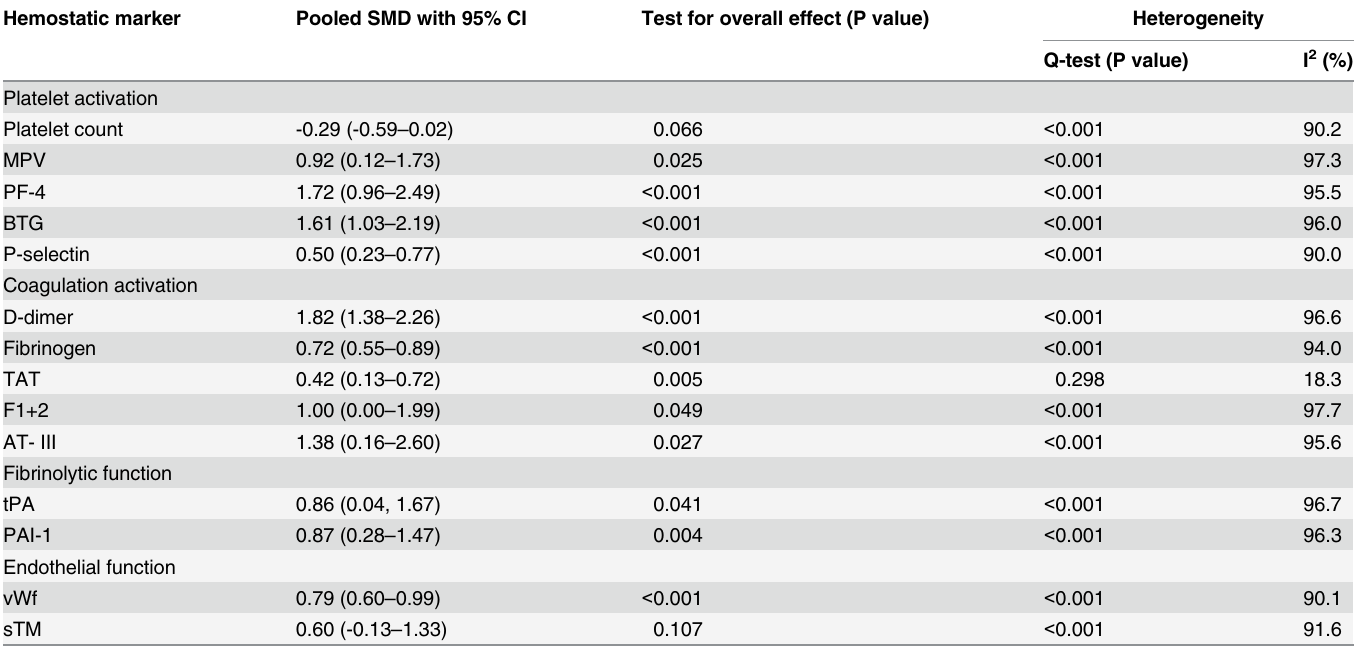
Table 1. Summary results of meta-analysis by hemostatic markers. Hemostatic